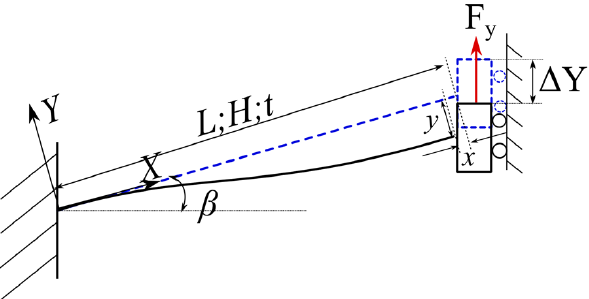
Figure 8. Schematic of the bistable